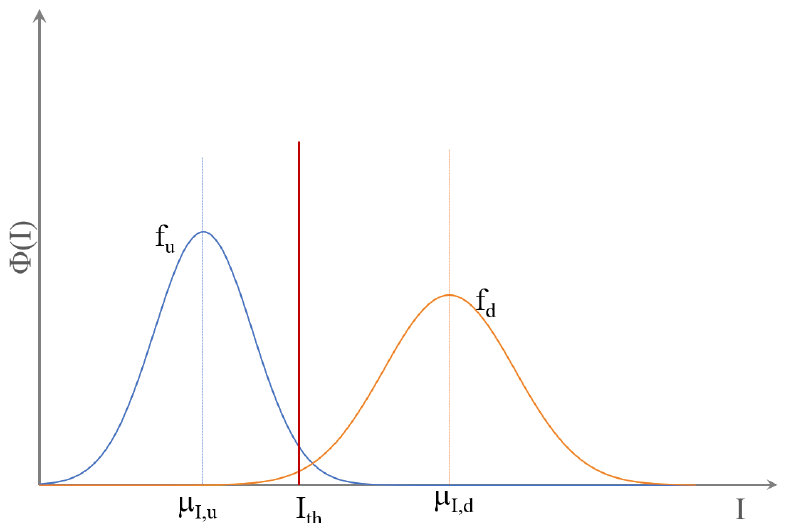
Figure 7. Distribution of the damage indicator in the undamaged and damaged